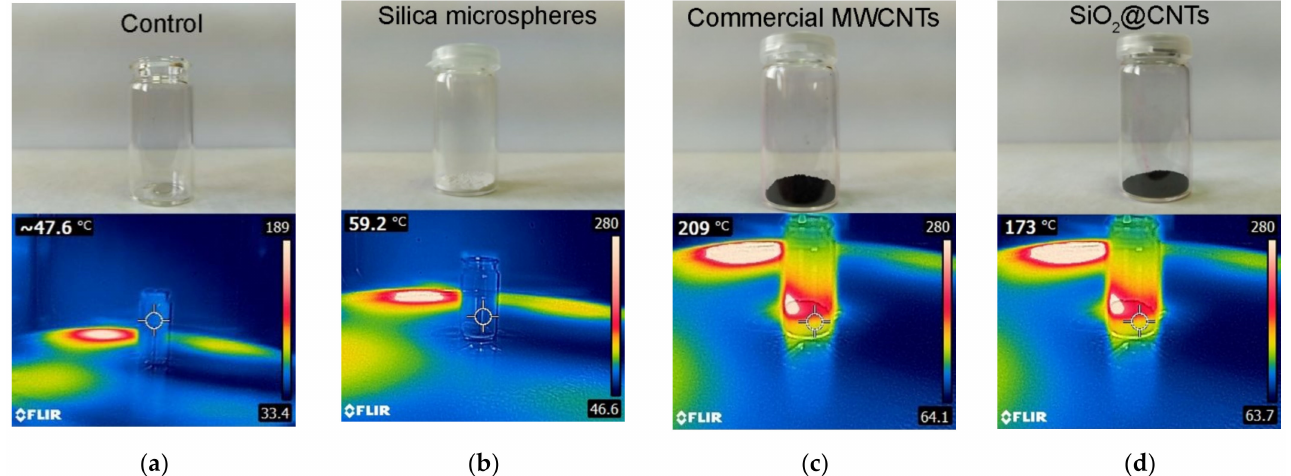
Figure 8. Photographs of the samples prior to ( top ) and after their microwave irradiation ( bottom ): ( a ) an empty vial as a control; ( b ) silica microspheres; ( c ) pristine commercial MWCNTs; ( d ) SiO 2